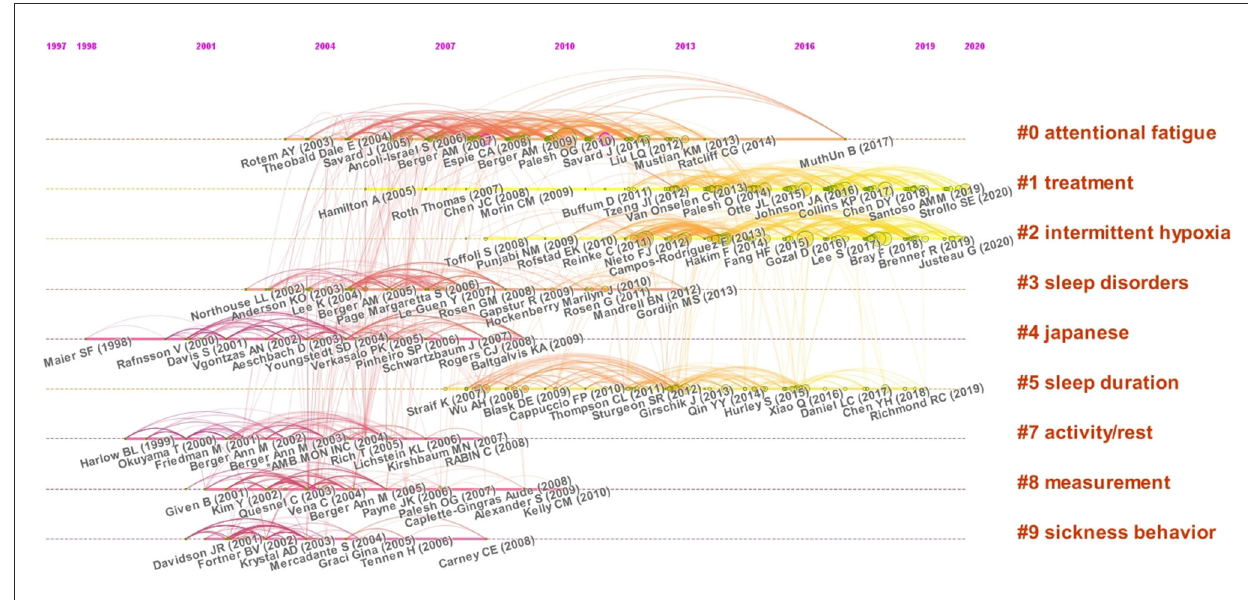
FIGURE7 Timeline of co-citation clusters on cancer and sleep research from 2002 to 2022.